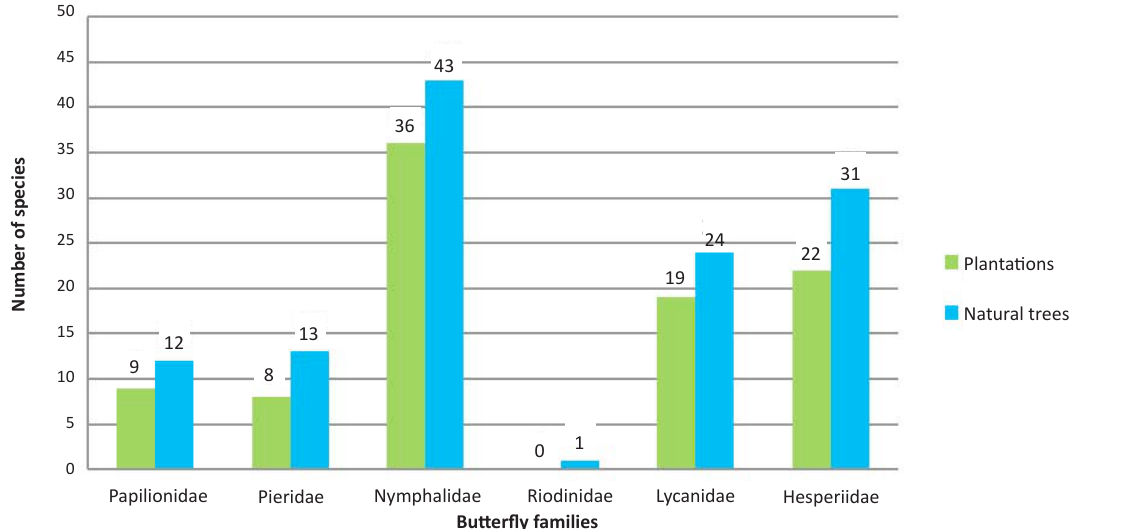
Figure 4. Habitat preference of the butterfly families at Kerala Agricultural University